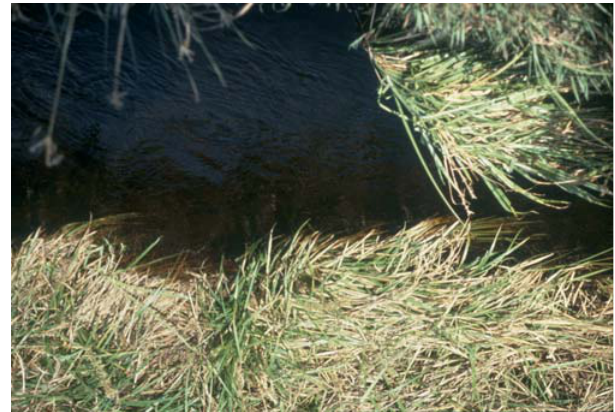
Fig. 60. Habitat of Mimagoniates lateralis , blackwater stream,